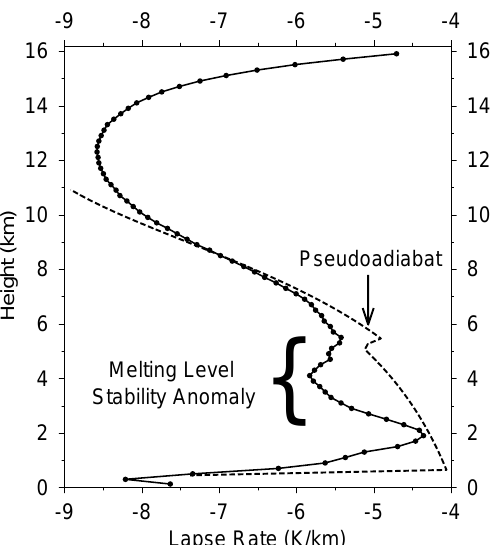
Fig. 3. The solid curve with bullets shows the mean lapse rate profile (1999–2008) of the five radiosonde stations discussed in this paper. The dashed curve shows the lapse rate profile of a parcel starting from the surface with a temperature of 299.5 K and relative humidity of 80%, and subjected to pseudoadiabatic ascent.